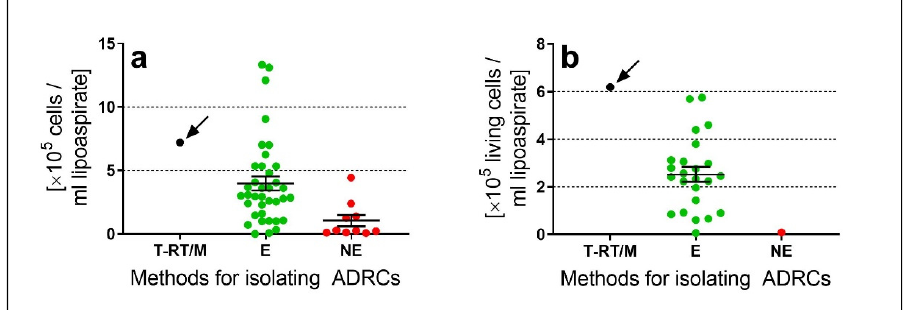
Figure 2. Comparison of cell yield ( a ) and number of living cells per mL lipoaspirate ( b ) of adipose derived regenerative cells (ADRCs) isolated with the Transpose RT / Matrase system (InGeneron) (T-RT / M; black dots) as well as other enzymatic (E; green dots) and non-enzymatic (NE; red dots) methods for isolating ADRCs reported in the literature (modified from [4]). The panels show individual data (dots) as well as mean and standard error of the mean (SEM) in case of the other enzymatic and non-enzymatic methods. One can immediately see that on average enzymatic methods result in a much higher cell yield than non-enzymatic methods. Furthermore, for most of the non-enzymatic methods the number of living cells per mL lipoaspirate could not be calculated because the corresponding relative numbers of living cells were not reported. Of all reported methods the Transpose RT / Matrase system (InGeneron) did not result in the highest cell yield (arrow in a) but in the highest number of living cells per mL lipoaspirate (arrow in b), which appears to be the clinically most relevant parameter (as outlined in the main text).